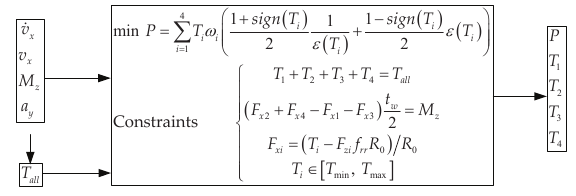
Figure 3. Minimal power optimisation procedure under M z